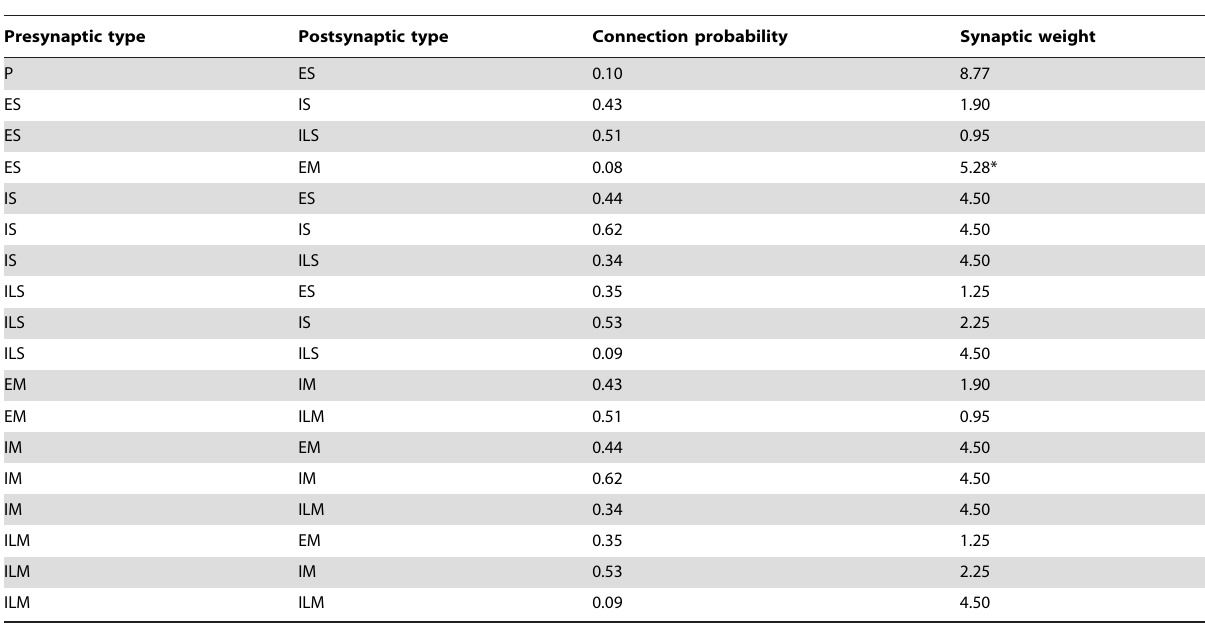
Table 2. Area interconnection probabilities and starting weight.